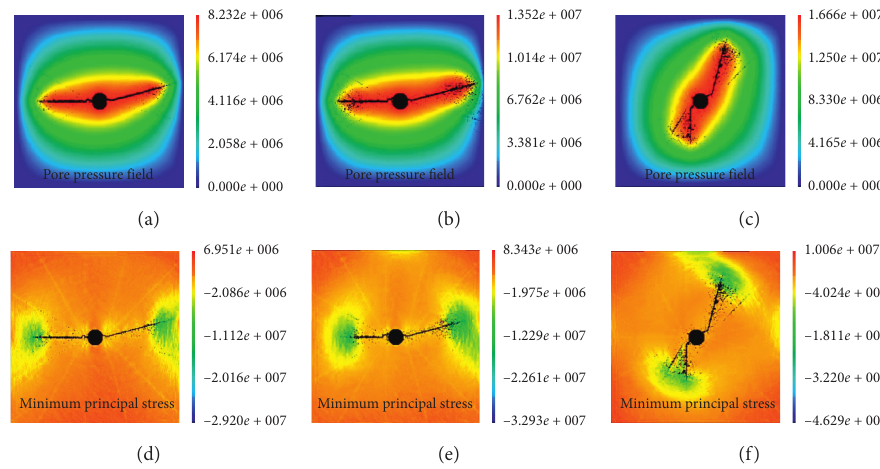
Figure 10: Simulation results of the multi-dip angle joint models. (a) σ (c) σ H � 10MPa and σ V � 10 MPa; (d) σ H � 10MPa and σ V � 5 MPa; (e) σ H � 10MPa and σ V � 8MPa; (f) σ H � 10MPa and σ V � 10MPa. Table 2: Physicomechanical parameters of the shale and joint employed in the simulation. Parameters Poisson’s ratio ( ] )